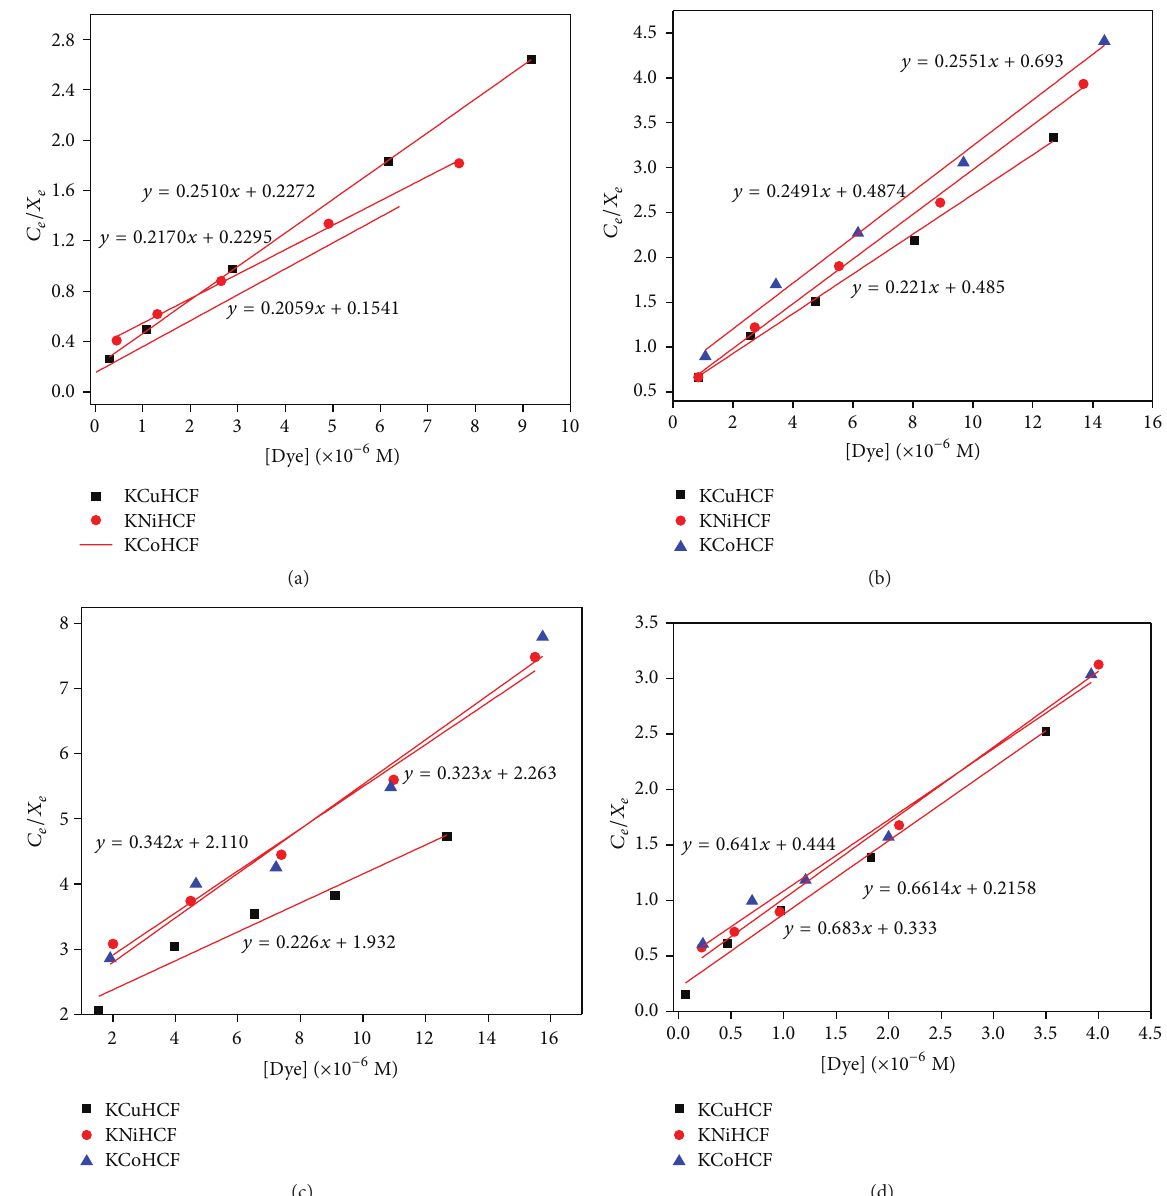
Figure 7: Langmuir isotherms for adsorption of (a) MG, (b) EBT, (c) MO, and (d) MB on KMHCF nanoparticles.